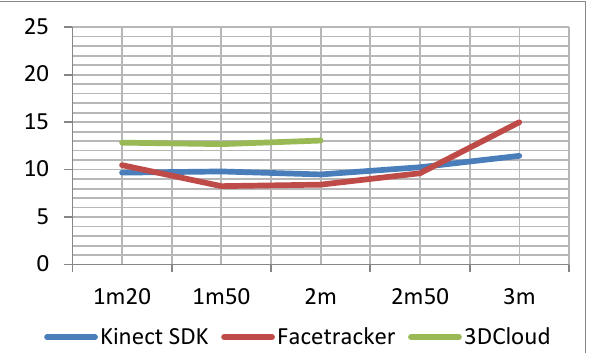
Figure 20. Mean RMSE (in degrees) for the roll function of the viewer distance from TV (in m).